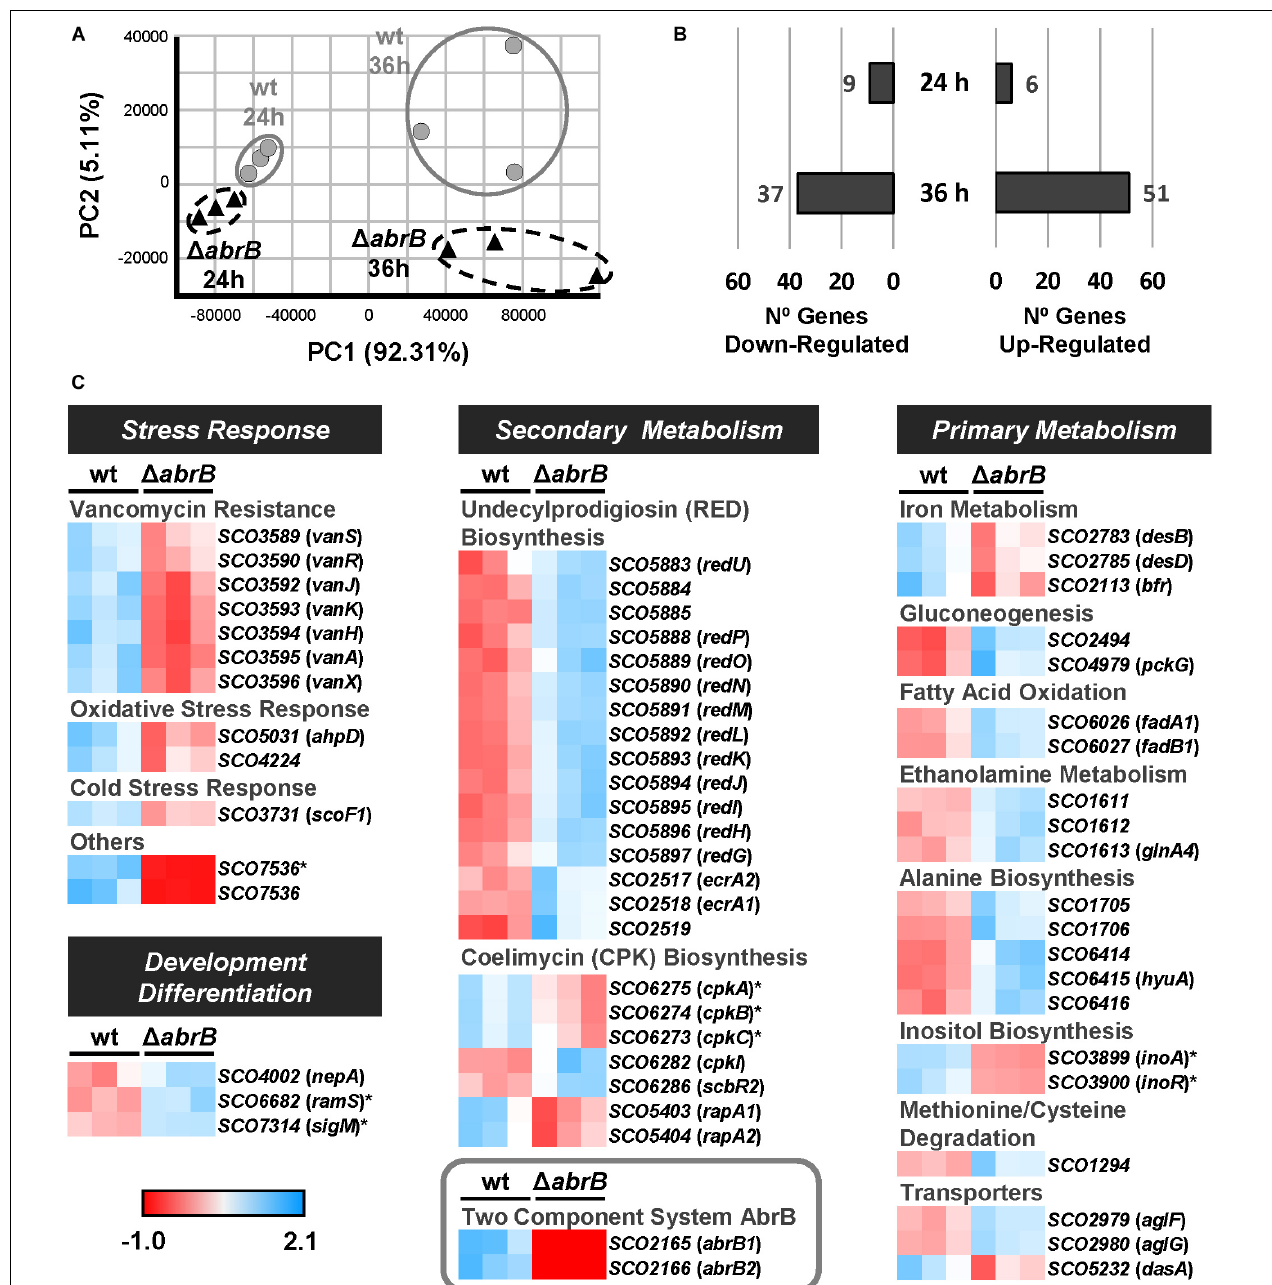
FIGURE 3 | Overview of RNA-Seq assay. (A) Principal component analysis (PCA) of the RNA-Seq samples: triplicates of the wt S. coelicolor M145 (wt; gray circles) and the mutant (cid:49) abrB (black triangles) at 24 and 36 h. (B) Number of up-regulated (FC > 2) and down-regulated (FC < –2) genes in the mutant strain relative to the wt at 24 and 36 h. The selected genes passed the filter of padj ≤ 0.05. (C) Heatmaps of standardized TPMs (transcripts per million) from the differentially expressed genes between S. coelicolor M145 wt and mutant (cid:49) abrB strains at 24 h (marked with asterisks) and 36 h. The genes with unknown functions or biological roles have not been